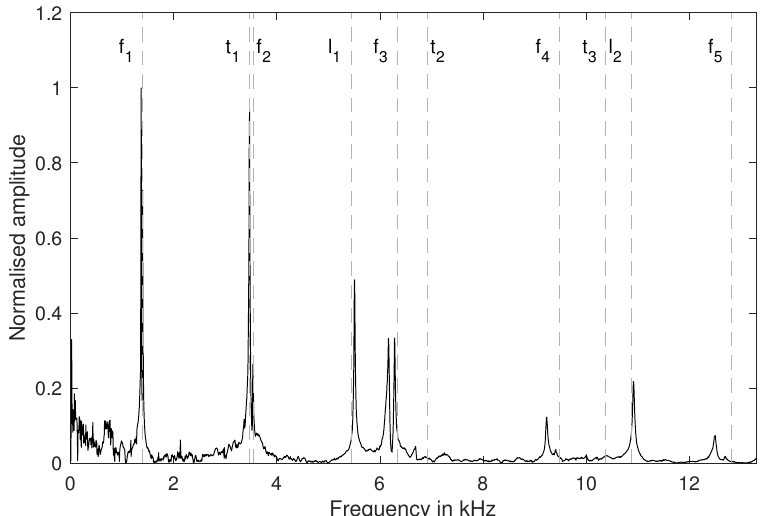
Figure 6. Spectral analysis of the impulse excitation data. The doted lines mark natural frequencies based on FEM calculations, with Young’s modulus and the shear modulus calculated analytically using f1 and t1,